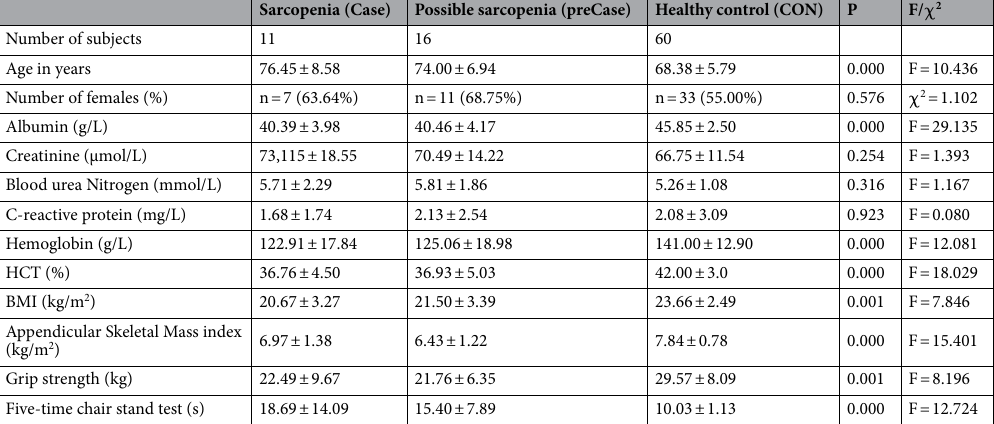
Table 1. Clinical and demographic parameters of enrolled subjects. All values are reported as mean ± standard deviation unless otherwise noted. All values are reported as mean ± standard deviation unless otherwise noted. Significant values highlighted in yellow.